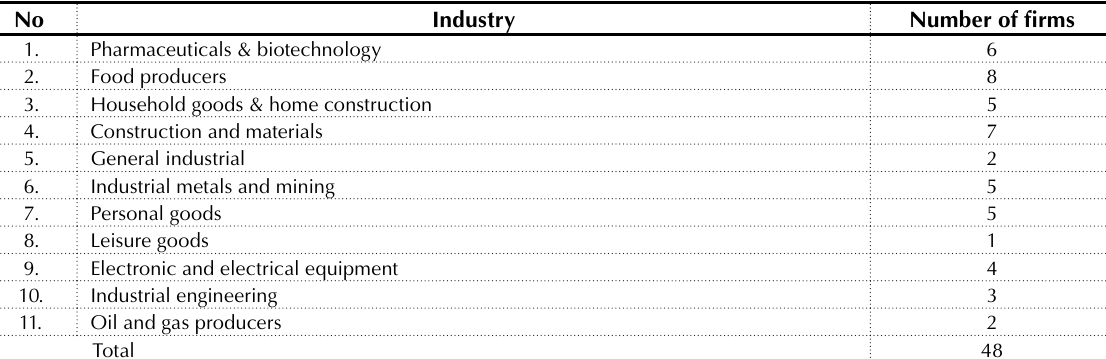
Table 1. List of firms and